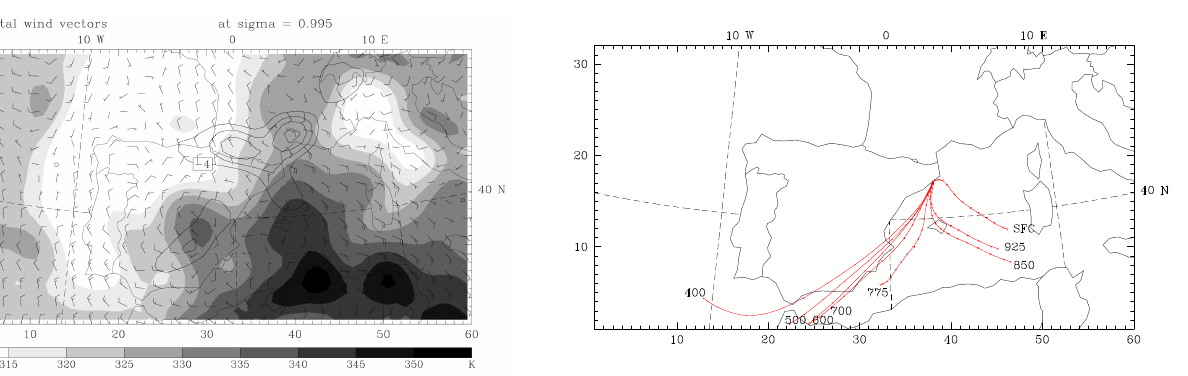
Fig. 5. The equivalent potential temperature at the lowest half model level (50m above the surface), the divergence at the low- est half model level and the surface windbarbs at 19:00 UT on 14 September 1999. The shaded areas indicate the θ e horizontal dis- tribution. The dashed contour lines reflect the horizontal negative divergence distribution smaller than − 4 × 10 − 5 s − 1 with a contour interval of 2 × 10 − 5 s − 1 .